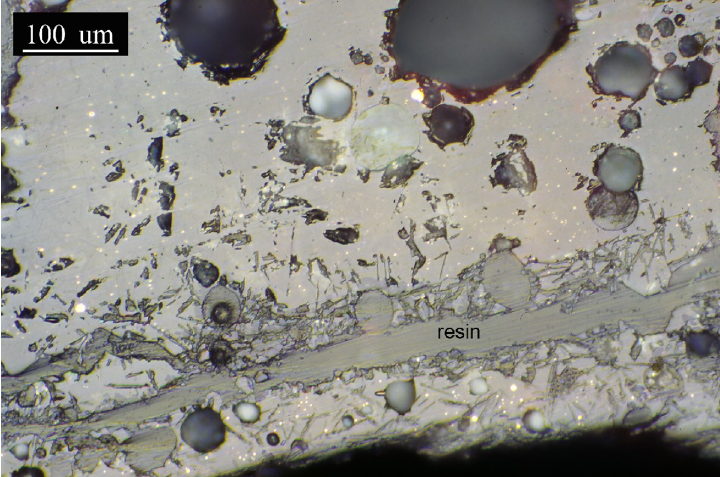
Fig 15. PPL micrograph of PA6327. Grey glassy slag matrix with abundant metallic prills. Silicate needles (dark grey) are scattered throughout the matrix. (Scale = 100 μ m).